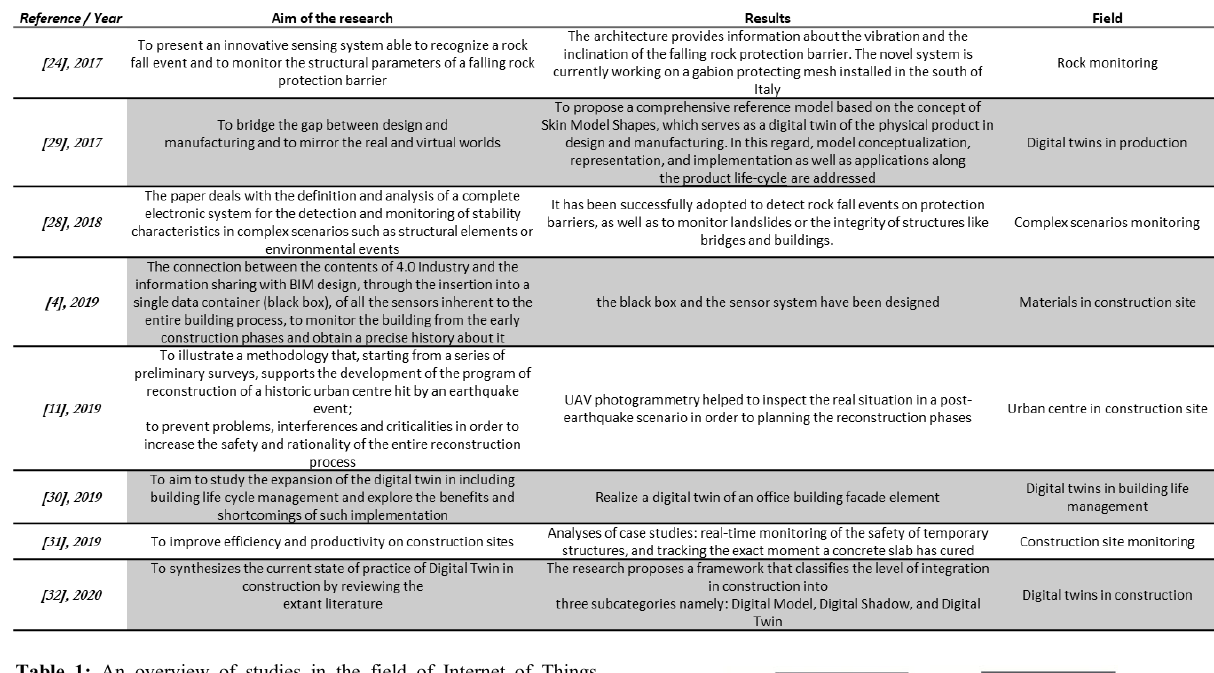
Table 1: An overview of studies in the field of Internet of Things applied to the construction industry